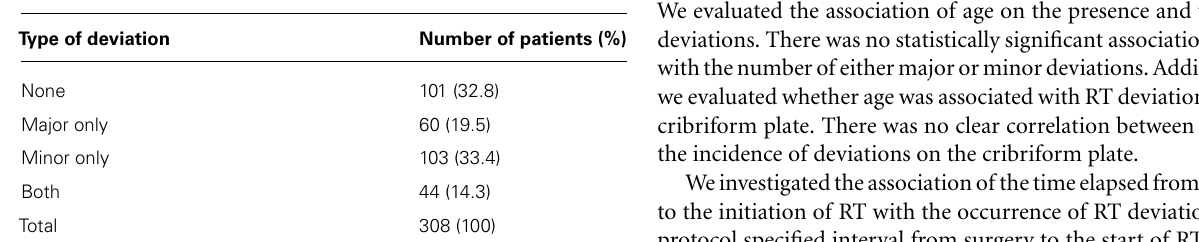
Table 1 | Summary of deviations for the 308 evaluable patients.